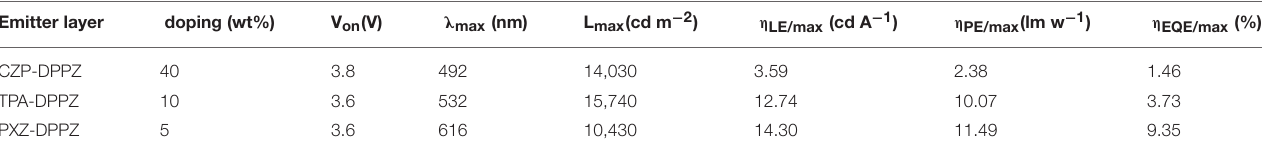
The device structure is: HATCN(5nm)/TAPA(30nm)/TCTA(10nm)/CBP: emitter(wt%)(20nm)/TPBi(30nm) /LiF(1nm)/Al(100 nm).